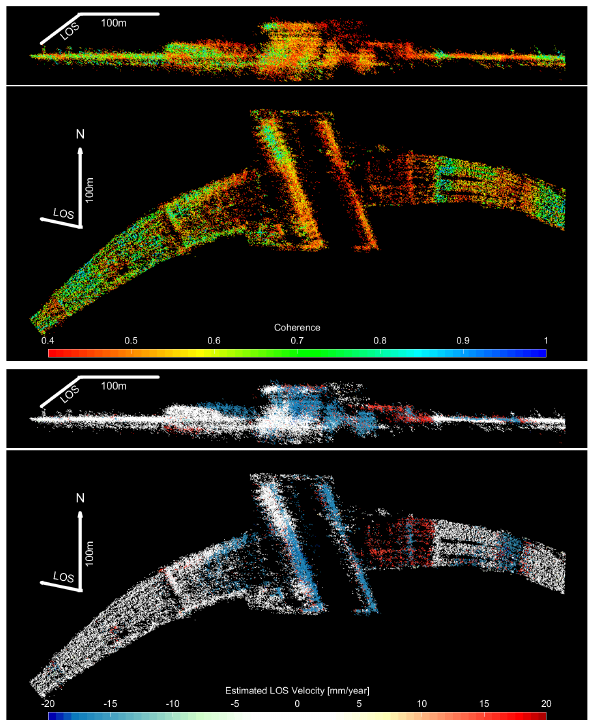
Figure 10. PS-points on Berlin Central Station from side and top view. Top: with color coded temporal model coherence. Bottom: with estimated linear velocities (linear model). Figure 8. Top/Middle: SLC Image with and without PS-points on Berlin Central Station . Bottom: Orthophoto of the same scene.